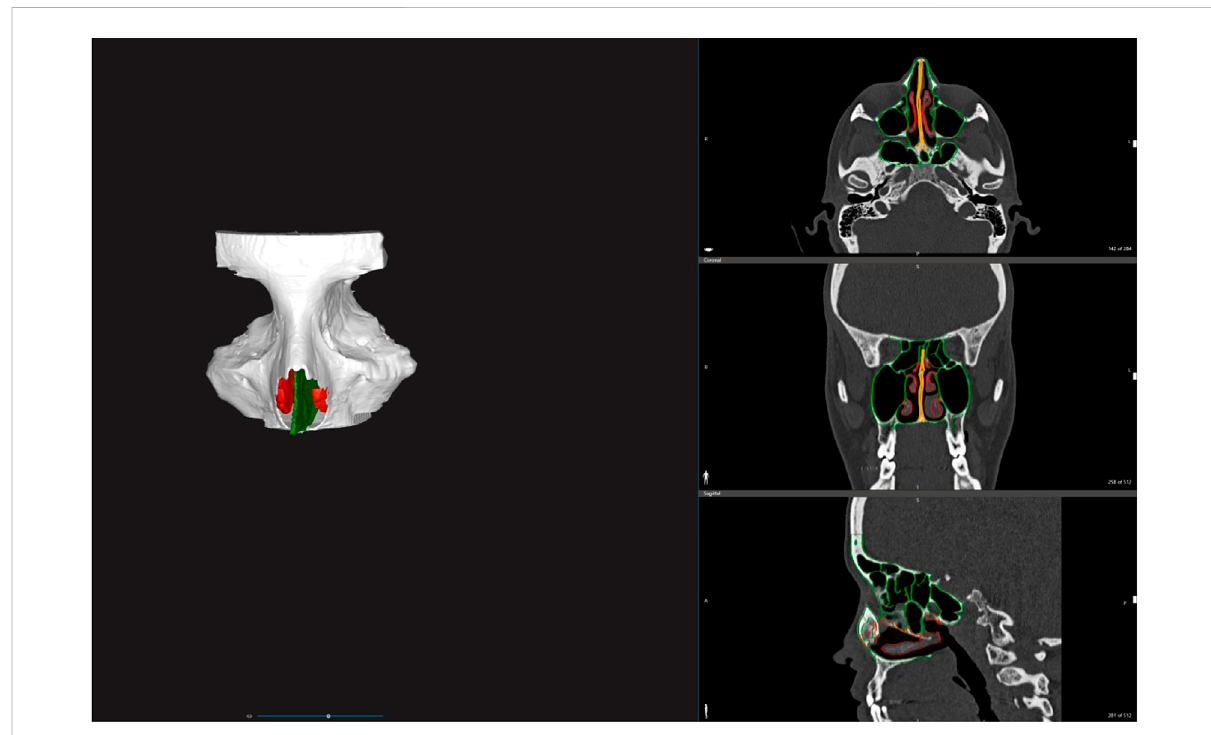
FIGURE 1 Segmentation and 3D rendering of the bony structures (white), the turbinates (red) and both bony and cartilaginous nasal septum (green).